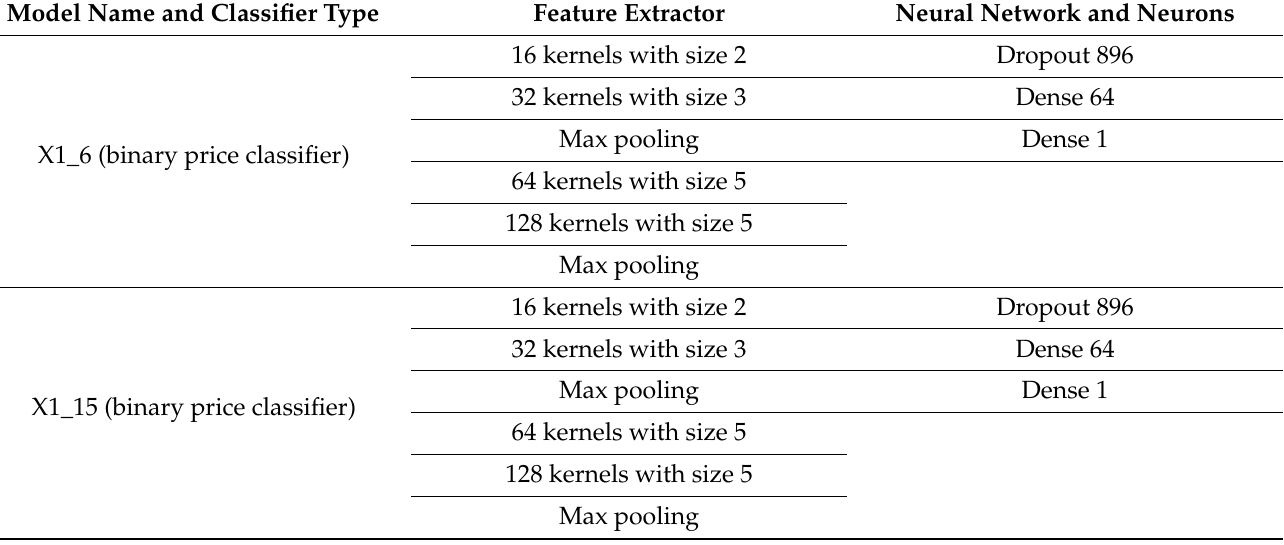
Table A1. Trained model architectures. All convolutional layers use stride 1 and valid padding, max pooling uses a stride of 2 unless specified otherwise. Dropout uses a 0.2 parameter. The flatten layer is not specified unless dropout was not used. The values written near the dropout indicate the flattened output of the feature extractor. Some models have the same architecture but different input sizes. Therefore, the feature extractor output is different for such networks. Multiclass classifiers compare future prices with the price of the last input element value and predict to which category price change in percentages will fall. The mapping converts the price change percentage to one of the three categories. If the mapping uses a range of 3, then the price change label is determined by the range in which the value falls: 3% + increase, from − 3% to 3%, or a greater decrease than −